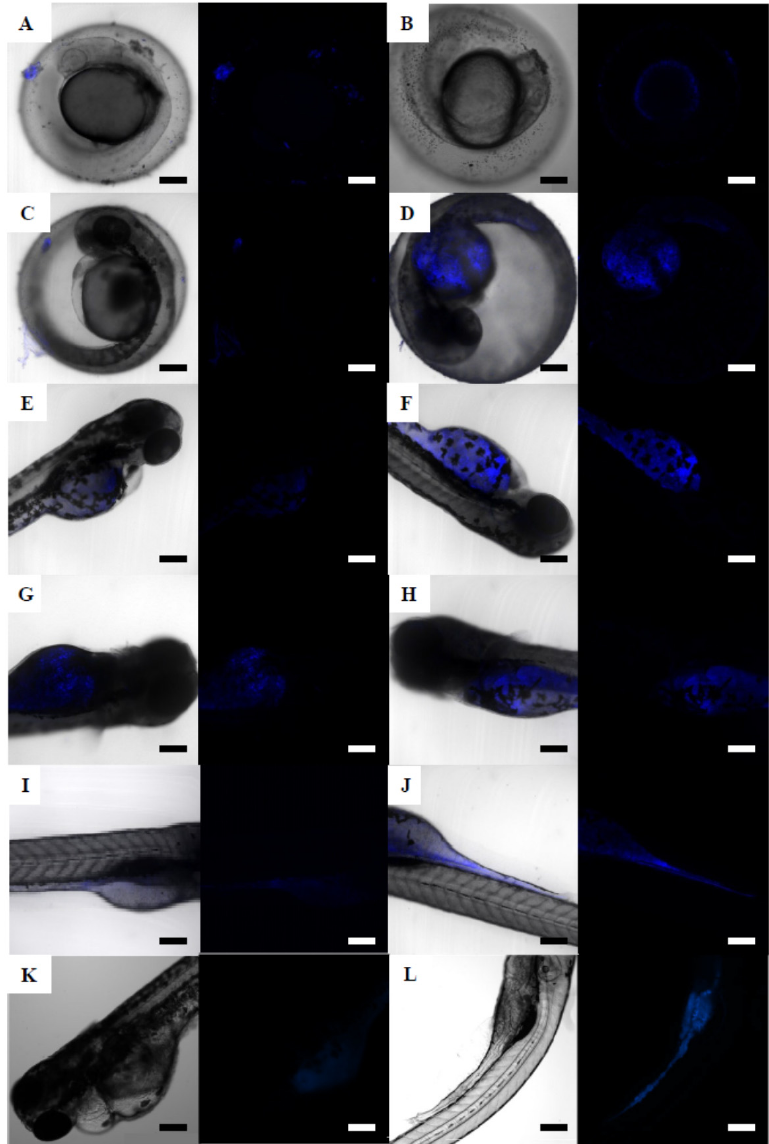
Figure 6. Confocal micrograph stacks of zebrafish embryos at different stages of development exposed to 4.5 µm MPs-B(a)P ( A – J ), and Cytation 5 micrographs of embryos exposed to B(a)P alone (K-L). ( A ) 24 hpf embryo exposed to 5.01 mg/L; ( B ) 24 hpf embryo exposed to 50.1 mg/L; ( C ) 48 hpf embryo exposed to 5.01 mg/L; ( D ) 48 hpf embryo exposed to 50.1 mg/L; ( E ) 72 hpf embryo exposed to 0.501 mg/L; ( F ) 72 hpf embryo exposed to 5.01 mg/L; ( G ) 96 hpf embryo exposed to 5.01 mg/L; ( H ) 96 hpf embryo exposed to 50.1 mg/L; ( I ) 120 hpf embryo exposed to 0.501 mg/L; ( J ) 120 hpf embryo exposed to 5.01 mg/L. ( K ) 120 hpf embryo exposed to 0.1 mg/L of B(a)P; ( L ) 120 hpf embryo exposed to 0.5 mg/L of B(a)P. Scale bars: 200 µm.